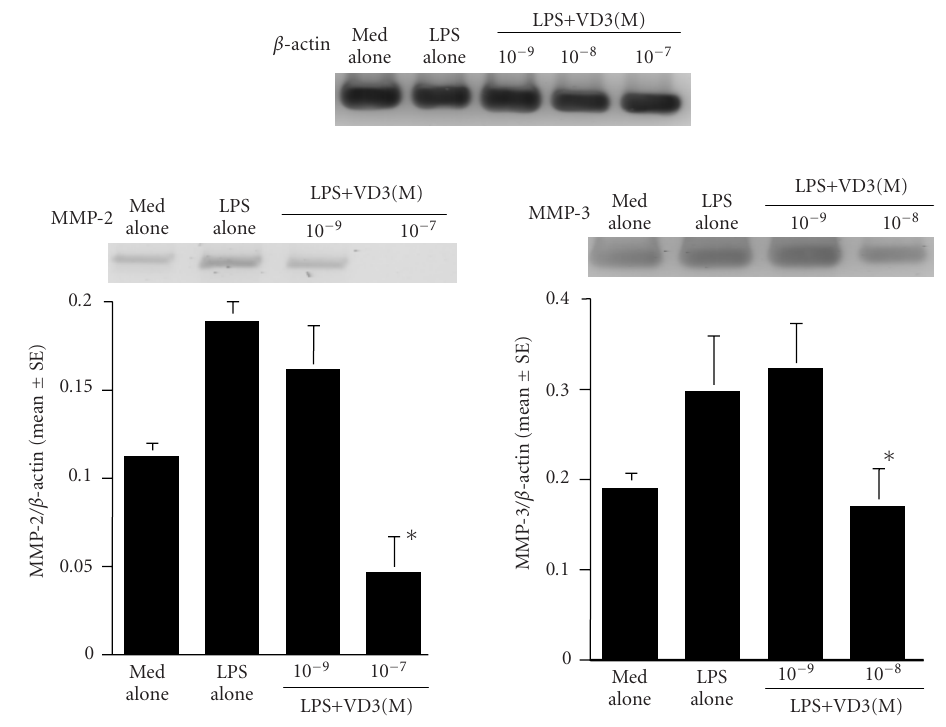
Figure 3. Influence of vitamin D3 on mRNA expression for MMP-2 and MMP-3 in keratinocytes after LPS stimulation. Keratinocytes (2 . 5 × 10 5 cells/mL) derived from cholesteatoma tissues were stimulated with 100 µ g/mL lipopolysaccharide (LPS) in the presence of various concentrations of vitamin D3 for 12 hours. mRNA expressions for MMP-2 and MMP-3 were examined by RT-PCR. Each set of data was expressed as the mean ratio (target/ β -actin) ± SEM of five di ff erent subjects.